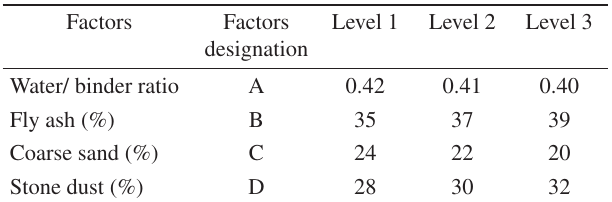
Table 1. Control factors and levels.